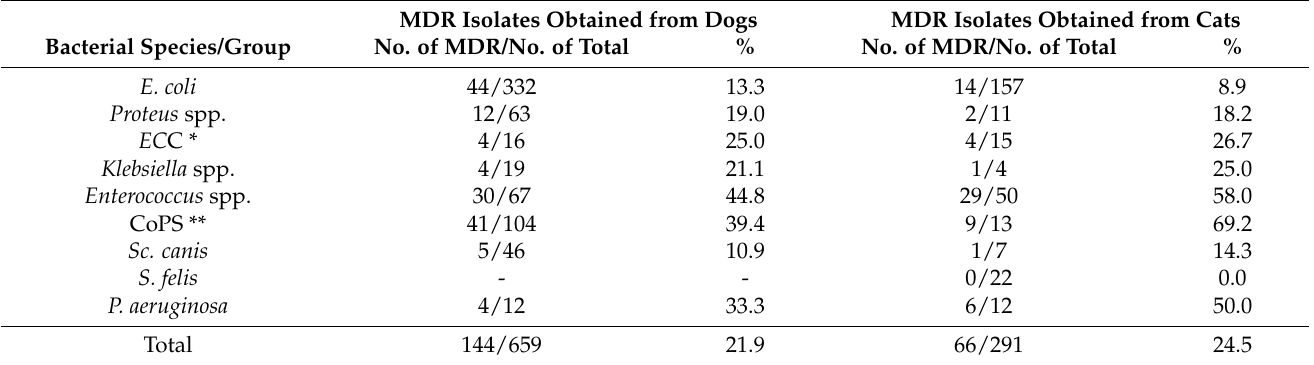
Table 4. Prevalence of bacterial isolates with a multidrug resistance pattern 1 from the total population, presented by bacterial and animal